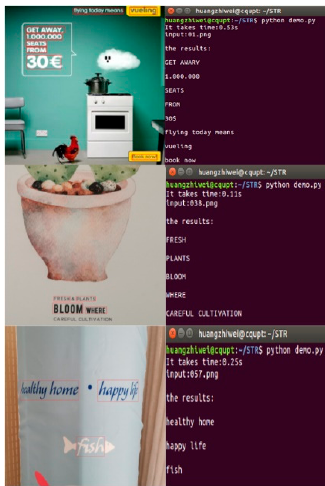
Figure 8. Experimental results of text recognition in a visual sensor scene image.